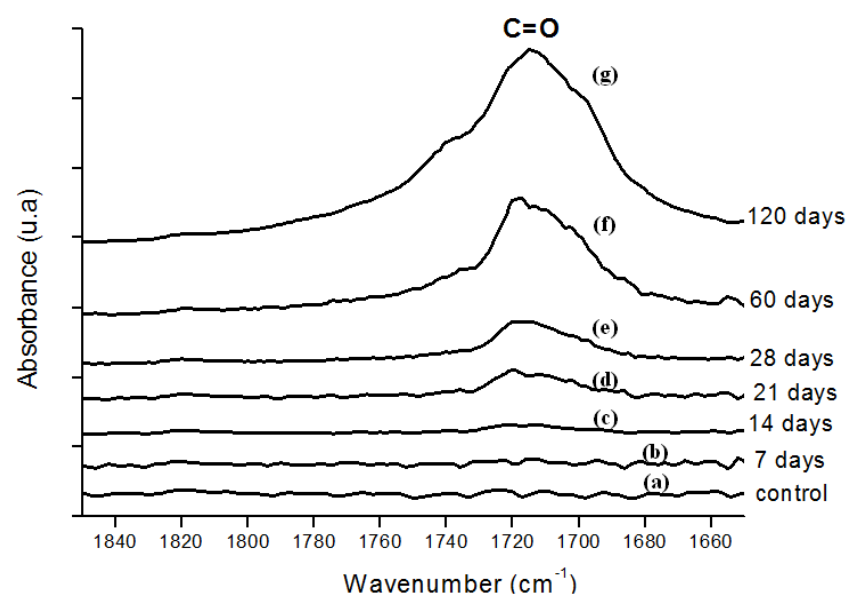
Figure 4. (a) FTIR spectra in the carbonyl (C=O) region of reference UHMWPE and UHMWPE submitted to peroxide accelerated ageing for different periods of time: (b)